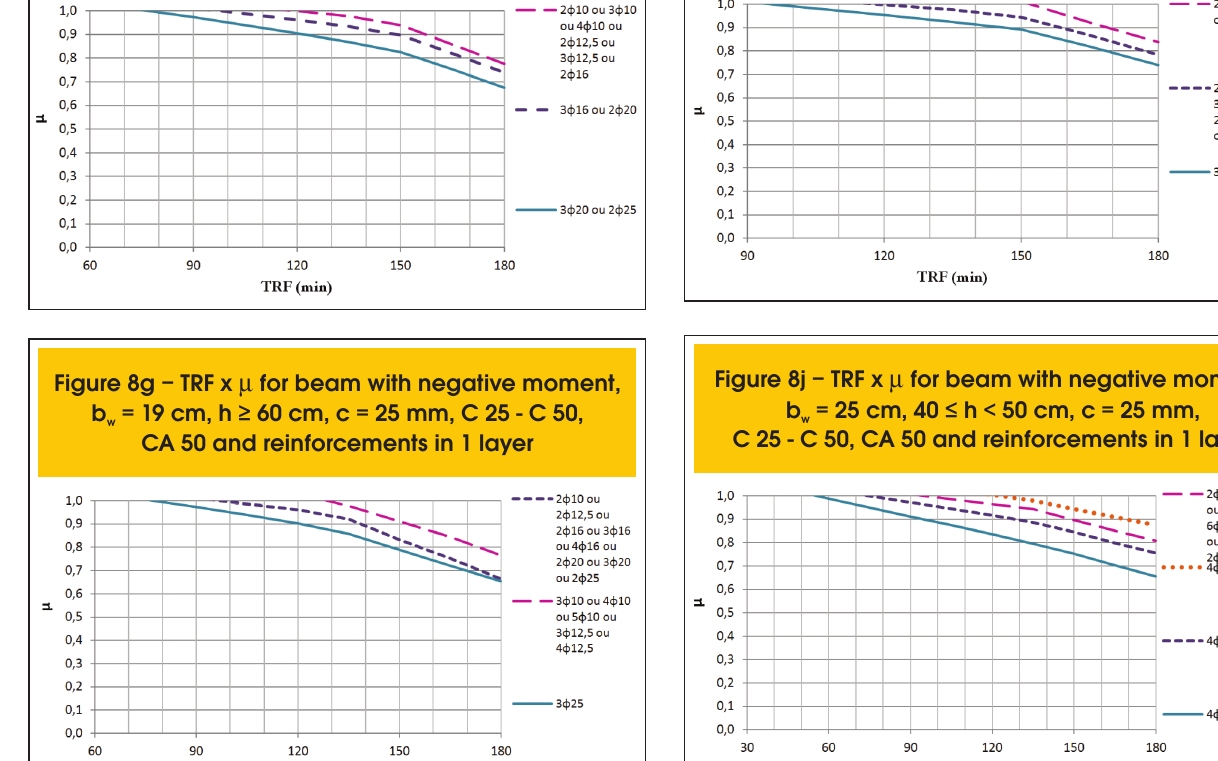
Figure 8f – TRF x m for beam with negative moment, b = 19 cm, 50 ≤ h < 60 cm, c = 40 mm, w